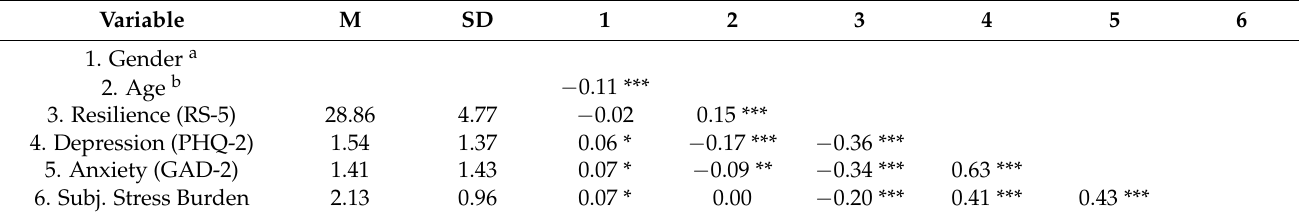
Table 2. Correlations between study